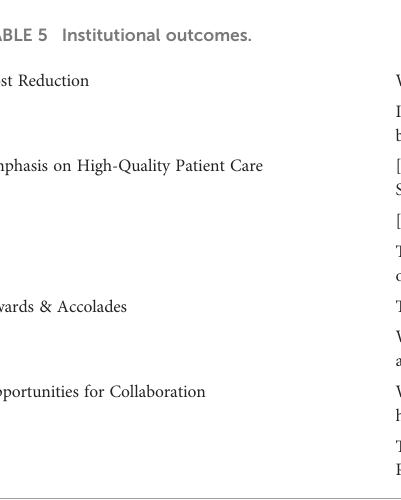
TABLE 5 Institutional